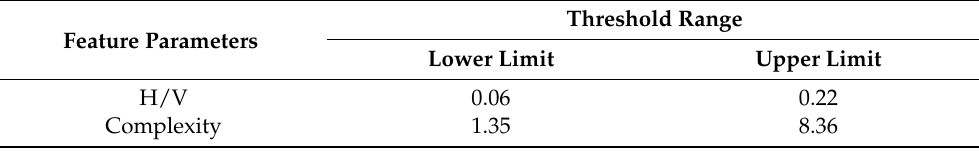
Table 4. Threshold range of feature parameters of S. frugiperda .